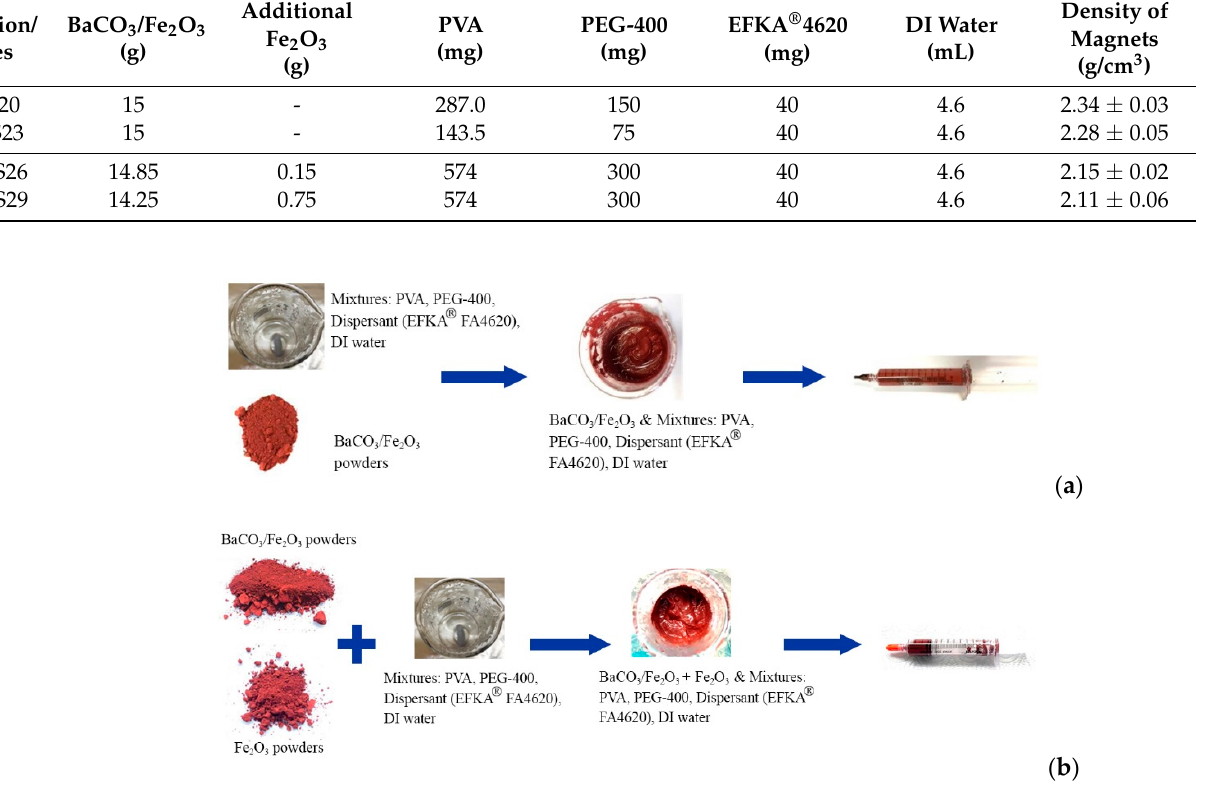
Figure 1. Steps of paste preparation for ( a ) formulations I-II and ( b ) formulations